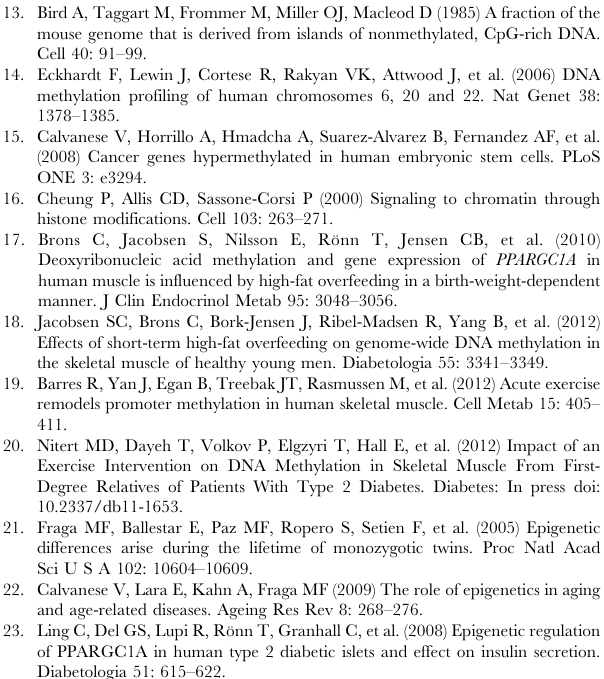
Table S1 Primer sequences. Table S2 Molecular pathways with a significant frac- tion of differentially methylated genes. No overlap denotes the fraction of genes in each pathway which was not represented on the array. The direction of methylation change in type 2 diabetic versus non-diabetic twins is indicated by arrows ( q : increased, Q :